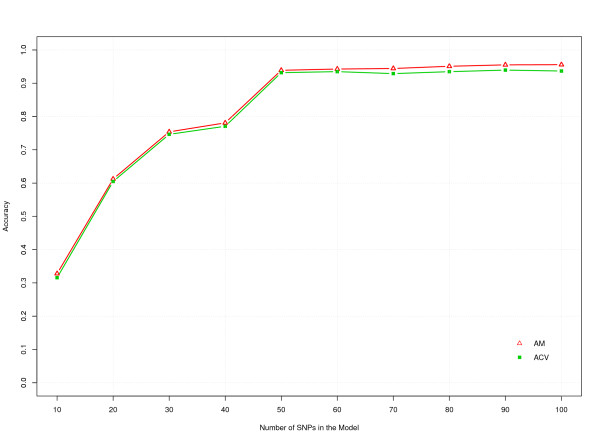
The accuracies of predicting the CNV by surrounding SNP estimated by cross-validation (ACV, green boxes) and the model accuracies (AM, red triangles).